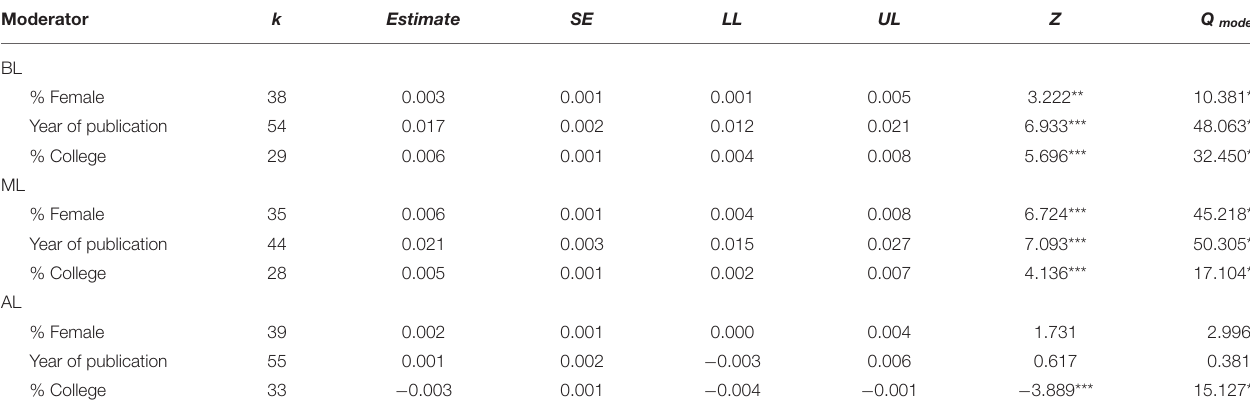
TABLE 4 | Moderating effects of continuous variables (meta-regression